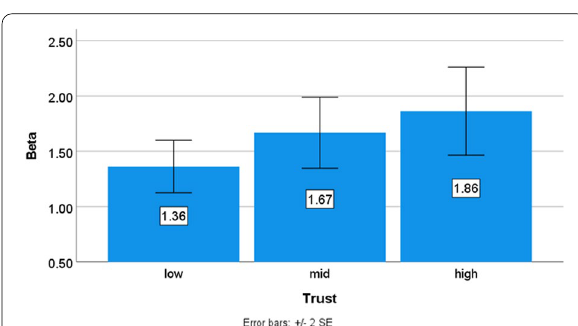
Fig. 6 Average bias scores per level of trust in the authenticity of a banknote. When images were presented until response, a high trust has led to a more conservative bias, i.e. a lower tendency to declare a banknote a counterfeit. Error bars depict 95% confidence intervals